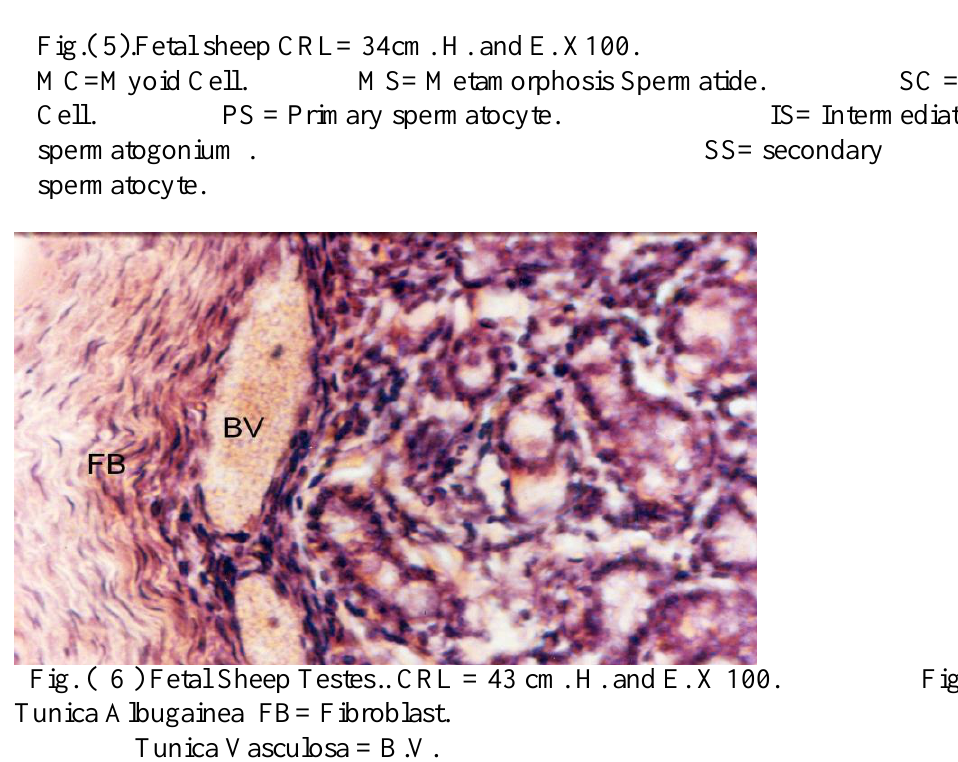
Fig.( 5).Fetal sheep CRL= 34cm. H. and E. X100. MC=Myoid Cell. MS= Metamorphosis Spermatide. Cell.